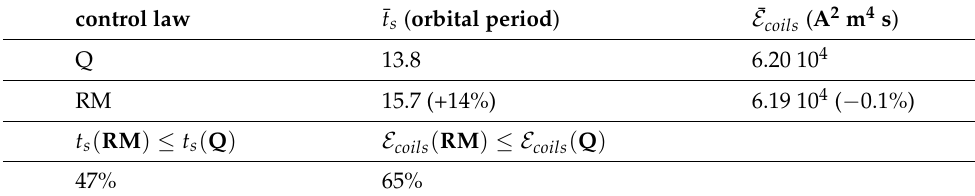
Table 4. Statistics of the Monte Carlo campaign for the nominal